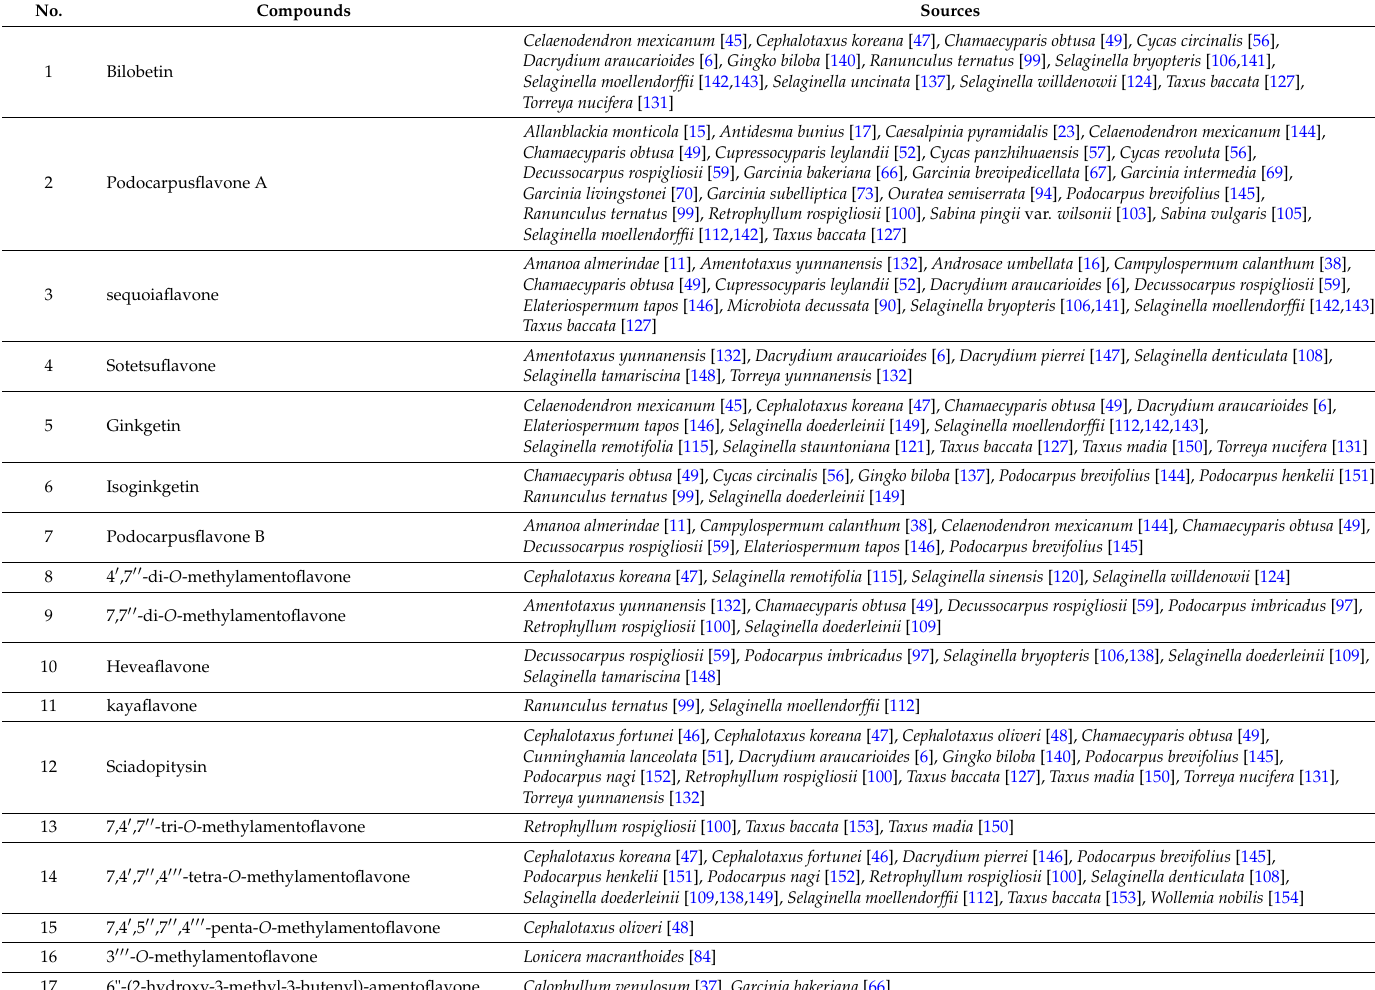
Table 2. Substituted derivatives of